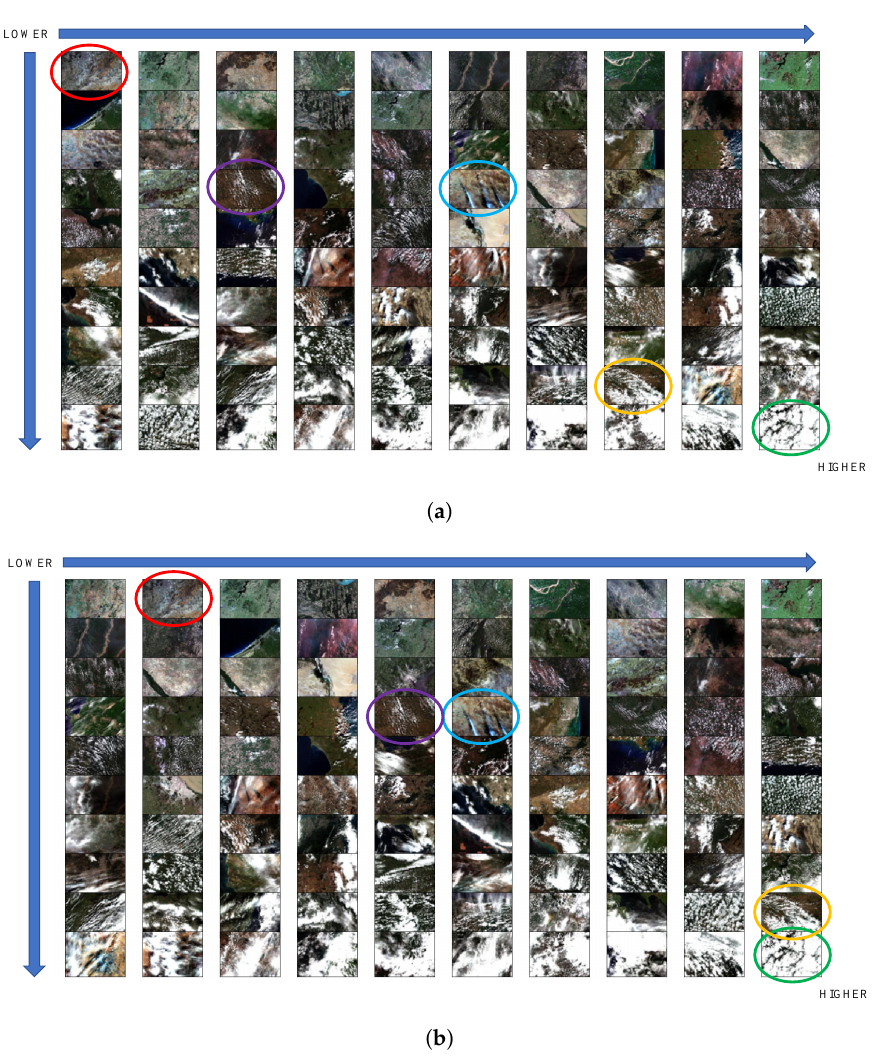
Figure 10. Comparison of PC rank vs. Embedded device rank in Sentinel-2 images. Colored circles are used to tag images. ( a ) Rank by PC; ( b ) Rank by embedded